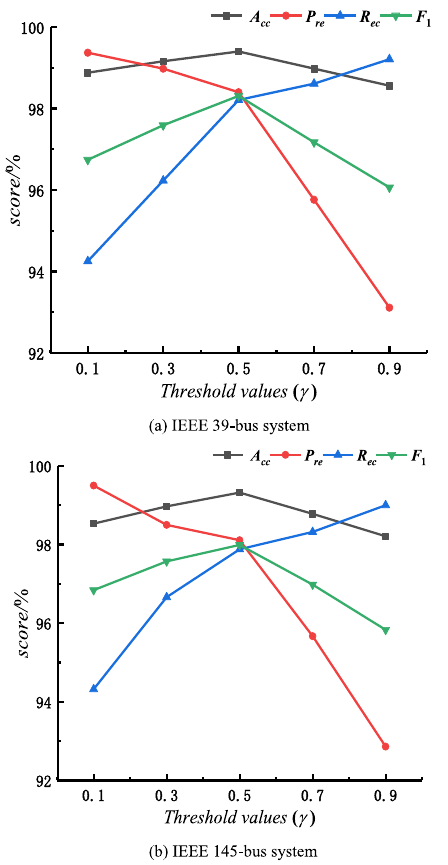
Fig. 11 TSA performance with different classification